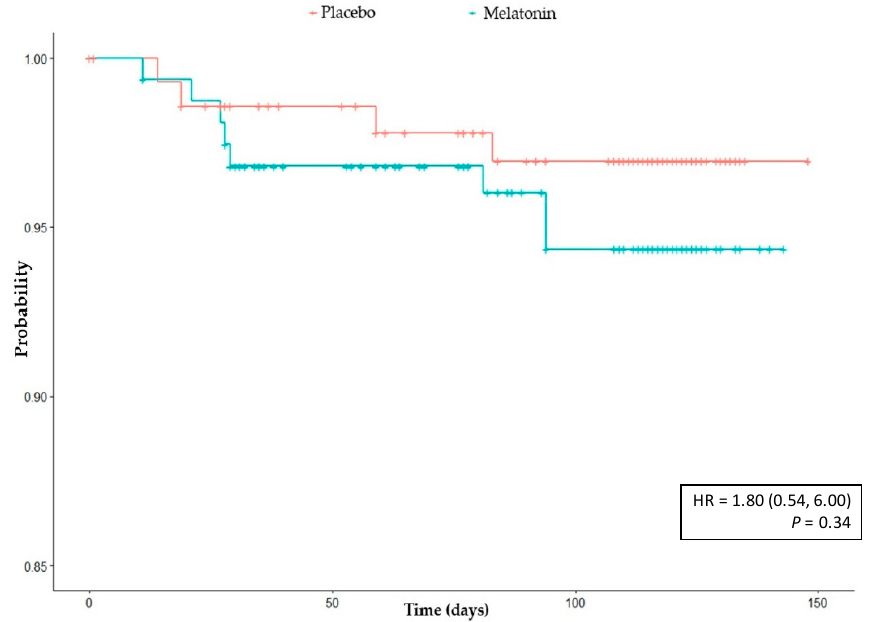
Figure 2. Kaplan–Meier analysis: time to infection. ITT population. Cox regression for the study of the influence of treatment was adjusted for sex, age and presence or absence of risk factors for Sars-CoV-2.